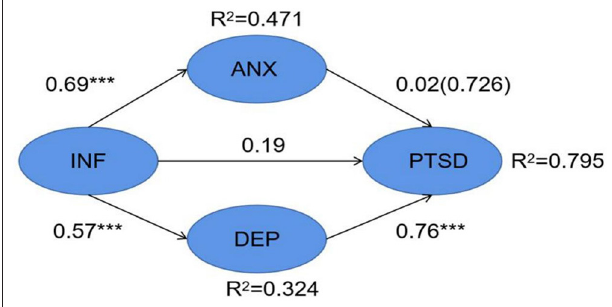
FIGURE 3 | Structural Model results showing path coefficients and coefficients of COVID-2019 information overload, anxiety, depression, PTSD. *** p <